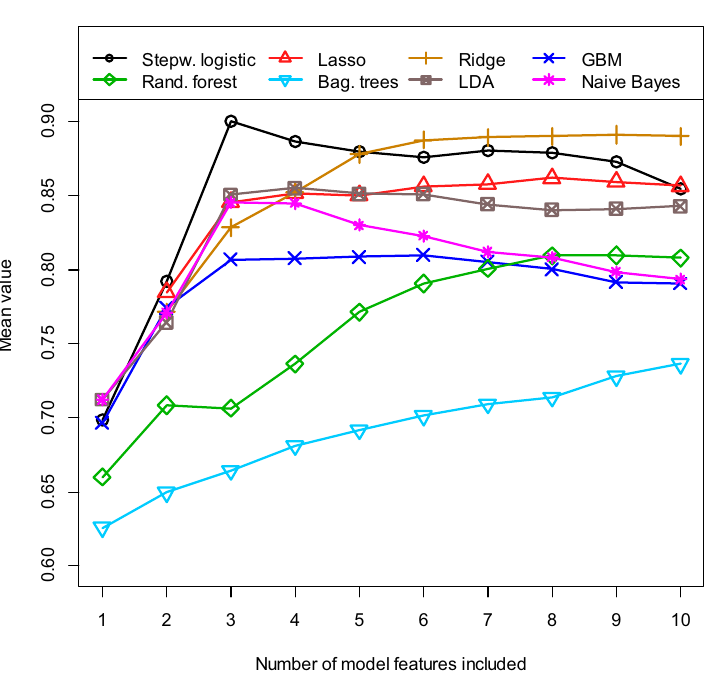
Figure 4. A rea U nder the C urve (AUC) for the test samples, calculated as means of 100 repetitions (100 cycles).